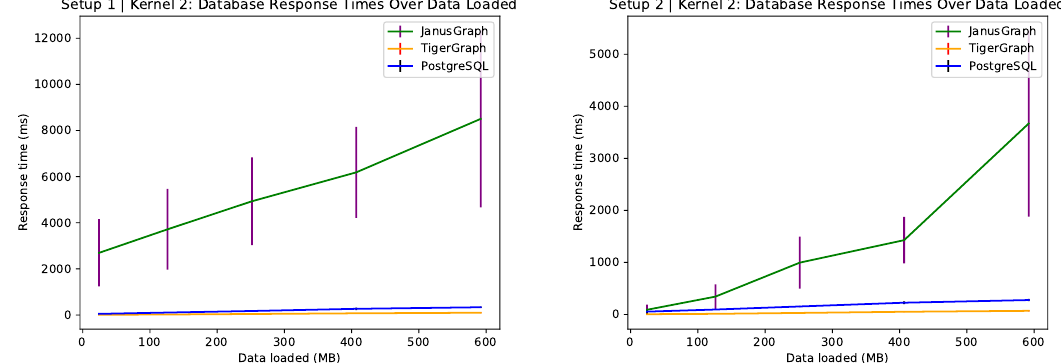
Figure 6. Database response times over varying percentages of the dataset for setup 1 and 2 for the kernel: “Review Trends in Phoenix 2018”. The error bars display standard